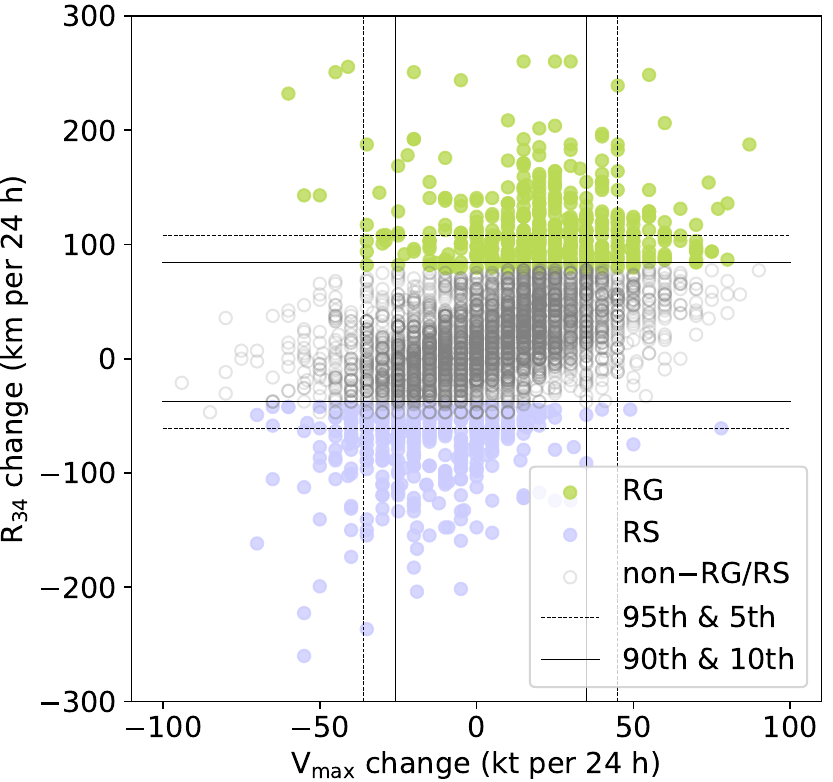
Figure 3. Distribution of intensity change (units: kt/24 h) and ∆ R 34 (units: km/24 h). The rapid growth (RG) and rapid shrinkage events identified by the isolation forest algorithm are denoted by green and purple dots, respectively, while the events not identified as RG or RS are denoted by grey circles. The thresholds of the 95th (5th) and 90th (10th) percentiles are denoted by dashed and solid lines,